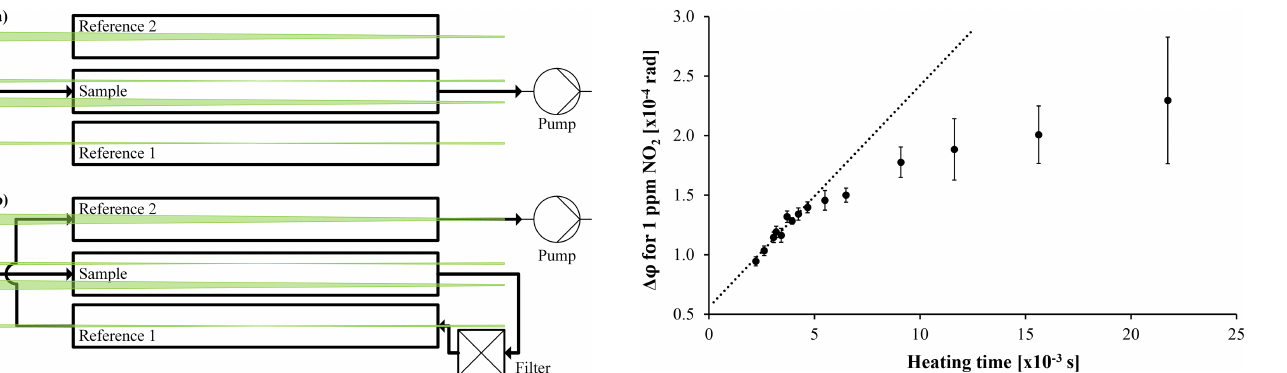
Figure 7. Gas flow system for the MSPTI prototype. Calibration measurements are performed, as in (a) , by filling the sample cell with the calibration gas and the reference cells with non-absorbing synthetic air. All three cells are connected for standard measure- ments, as in (b) , with the filtered sample flowing through both ref- erence chambers in sequence.